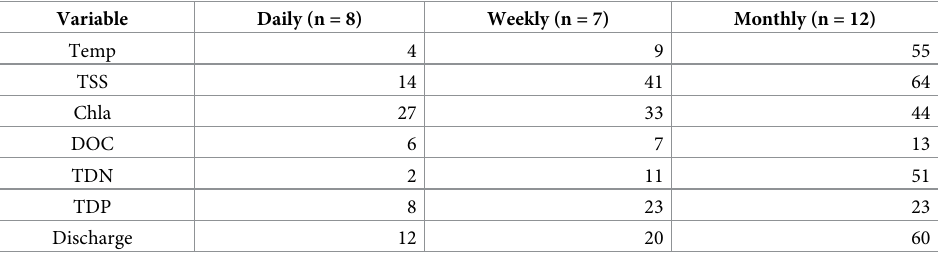
Table 1. Coefficient of variation (%) in environmental variables at daily, weekly, and monthly